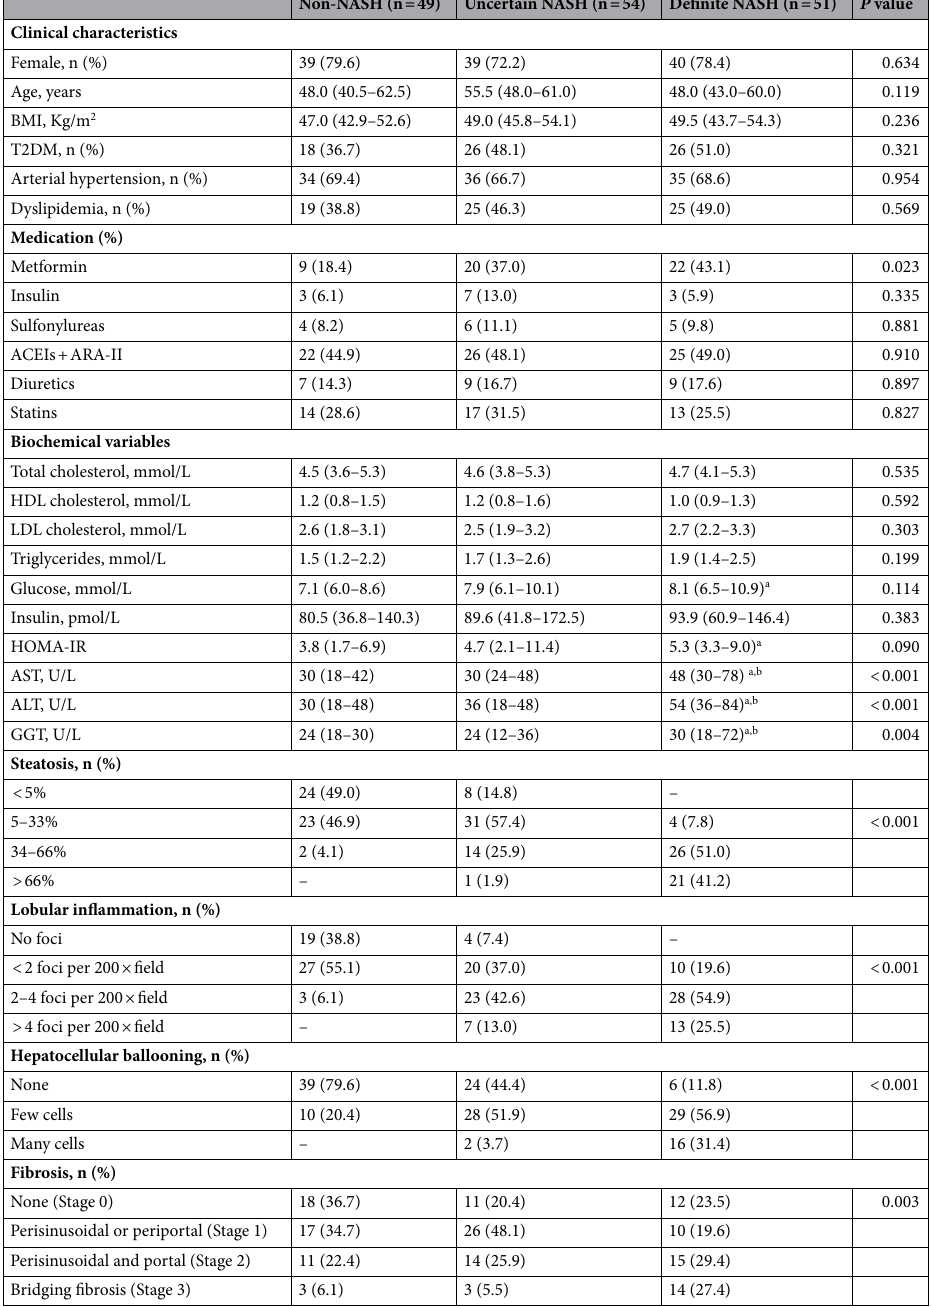
Table 1. Clinical, biochemical, and histological variables segregated with respect to the NAS score. Values are shown as number of cases and percentages, or medians and interquartile ranges. ACEIs angiotensin- converting-enzyme inhibitor; ALT alanine aminotransferase; AST aspartate aminotransferase; ARA-II angiotensin II receptor antagonists; BMI body mass index; GGT γ-glytamyl transferase; HOMA-IR homeostatic model assessment of insulin resistance; HDL high-density lipoproteins; LDL low-density lipoproteins; NAS nonalcoholic fatty liver disease activity score; NASH nonalcoholic steatohepatitis; T2DM type 2 diabetes mellitus. Superscript letters indicate significant (at least p < 0.05) differences between: a non-NASH vs. definite NASH; b uncertain NASH vs. definite NASH; *Global P value using the Kruskal–Wallis one-way analysis of